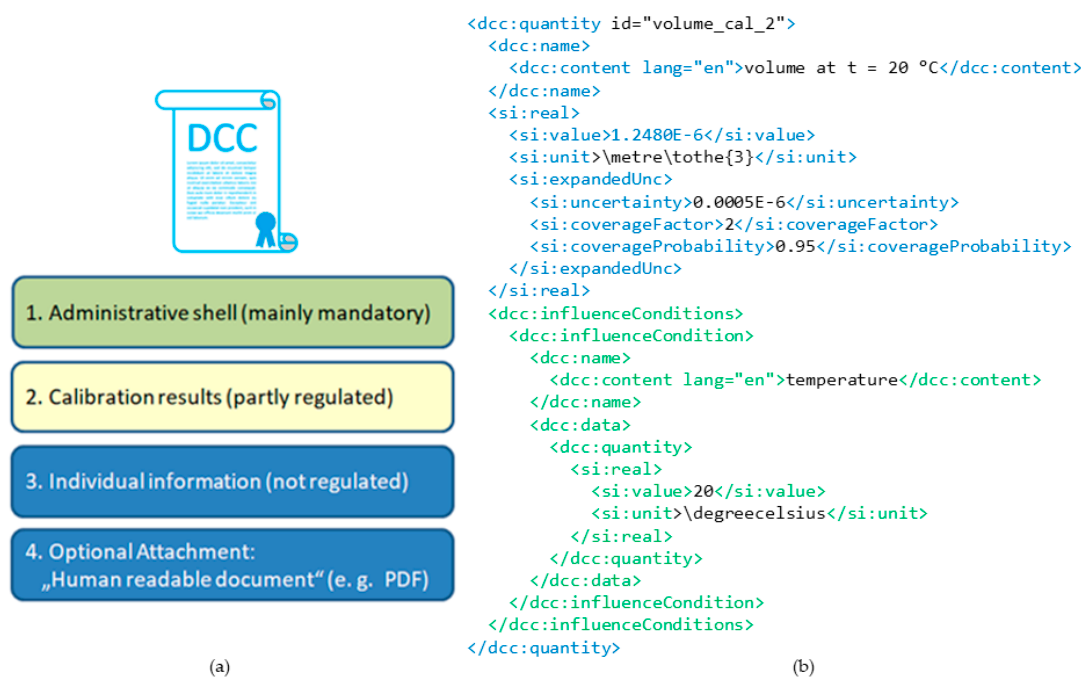
Figure 2. Example of the Digital Calibration Certificates (DCC) structure. High level syntax of the DCC ( a ) and an XML extract from a calibration result of a volume measurement ( b ).